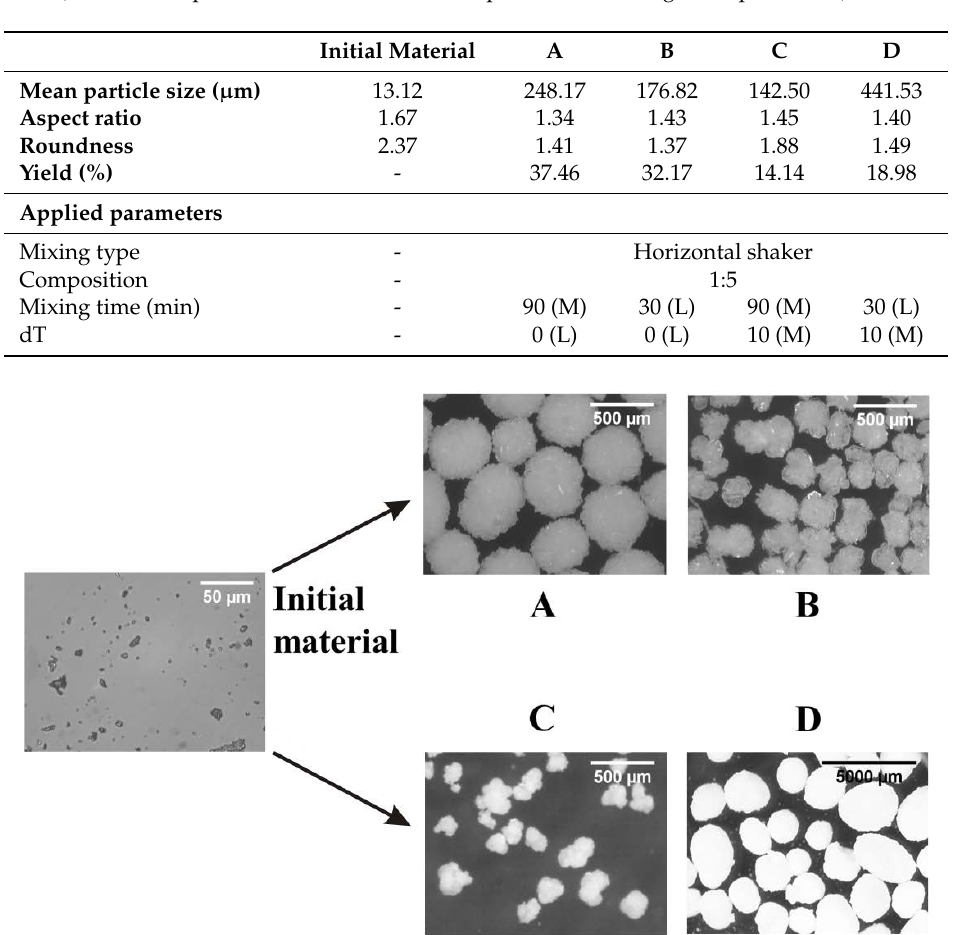
Table 6. Comparison of the initial material and the products made by the spherical agglomeration